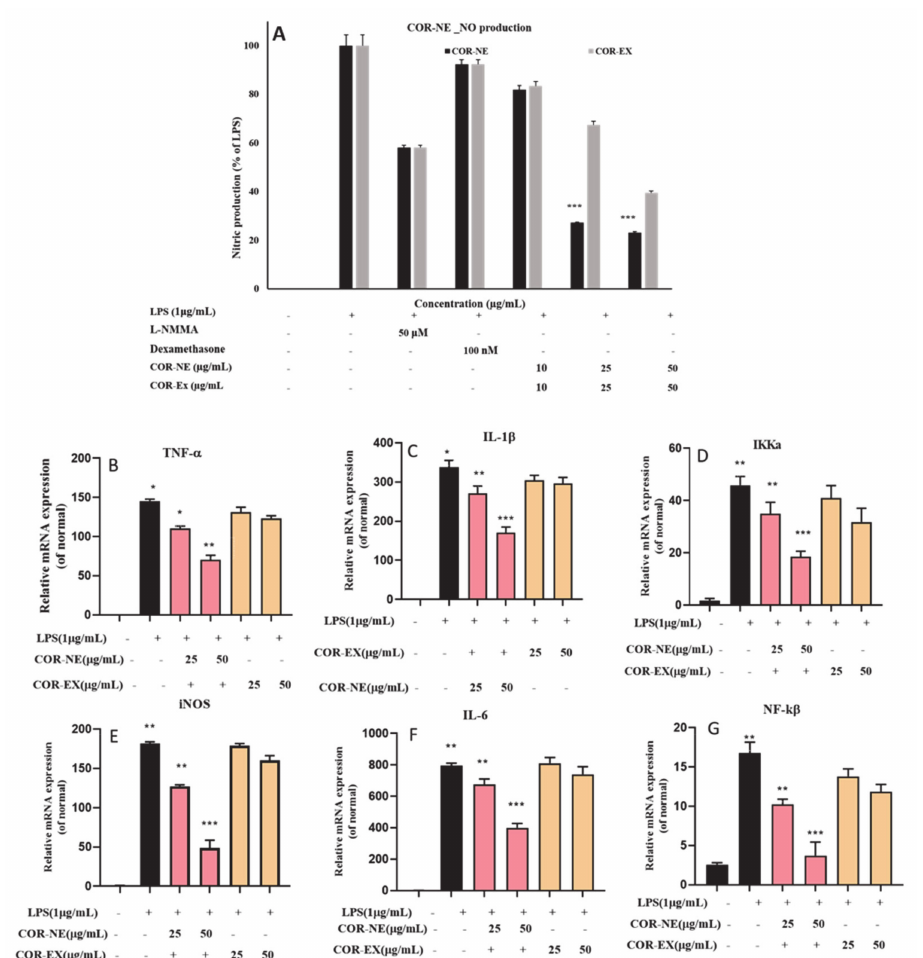
Figure 6. E ff ect of Cordyceps nanoemulsion on: ( A ) NO production and pro-inflammatory cytokines ( B ) TNF- α , ( C ) IL-1 β , ( D ) IKKa, ( E ) iNOS, ( F ) IL-6, and ( G ) NF-kß mRNA expression in LPS-induced RAW 264.7 cells. Each value is expressed as the mean ± standard error of three independent experiments. * p < 0.05, ** p < 0.01, *** p < 0.001 compared with